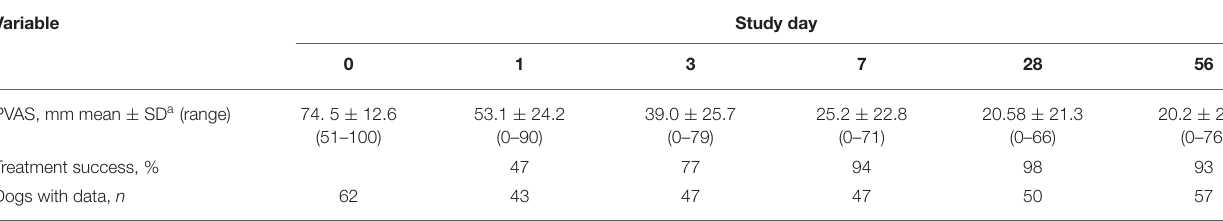
TABLE 4 | Mean PVAS and treatment success. Variable